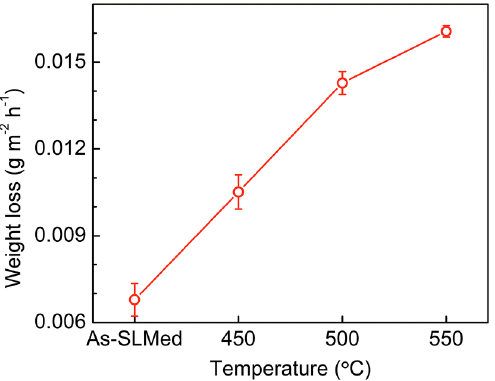
Figure 10. Weight loss of untreated and additionally heat-treated SLM AlSi10Mg alloy [67].